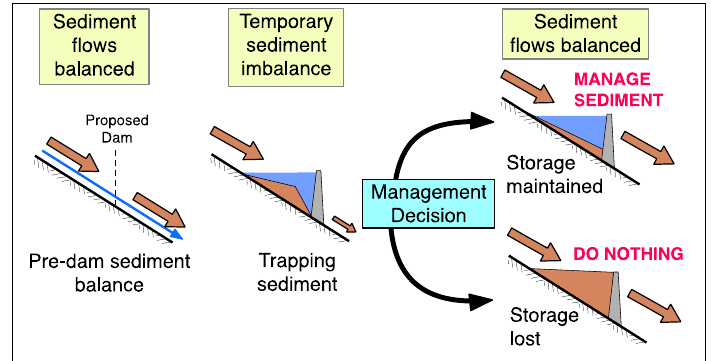
Figure 1. Alternative transitions from pre-impoundment to post-impoundment sediment equilibrium. To maintain long-term reservoir storage is a management decision.